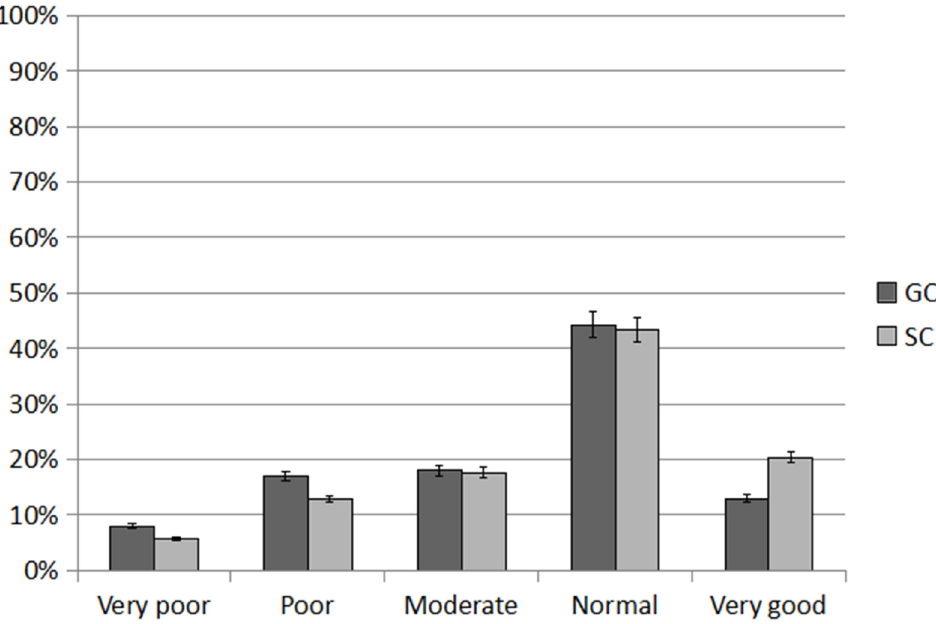
Figure 5. General physical fitness, the average of all fitness tests results. GC—general education classes; SC—sport classes.